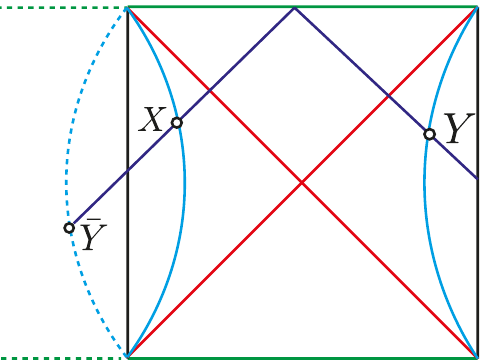
Figure 5 . Illustration of the null rays involved in fixing the critical static time t c , after which symmetric geodesics between the two stretched horizons do not exist